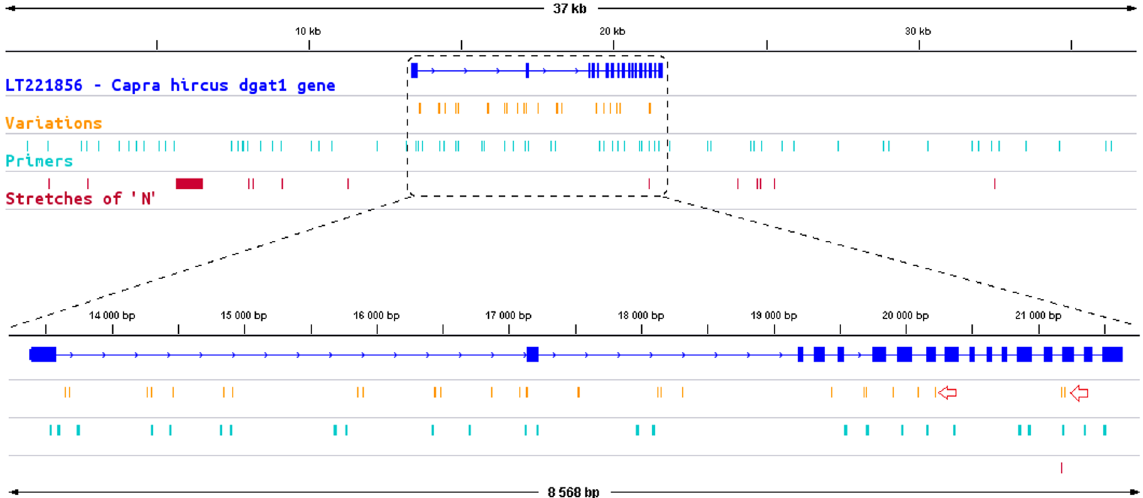
Figure 4. Determination of DGAT1 gene structure and polymorphism. The intron/exon structure of the LT221856 sequence is shown together with the SNPs detected and the primers used for sequencing. The location of the remaining N stretches is shown, together with their length (bp). A zoom on the coding region is also shown. The red arrows indicate the position of the R251L and R396W mutations.